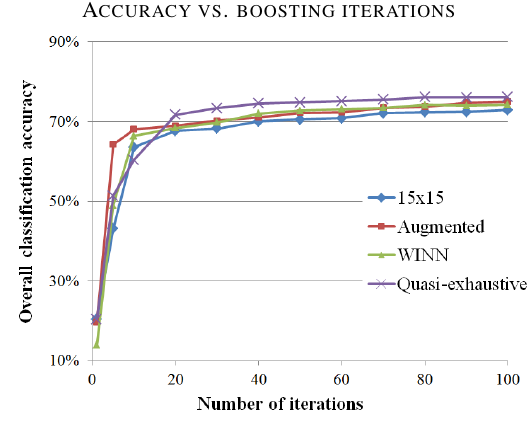
Figure 2: Classification accuracy versus training iterations of the boosting classifier for test scene V AIHINGEN (without